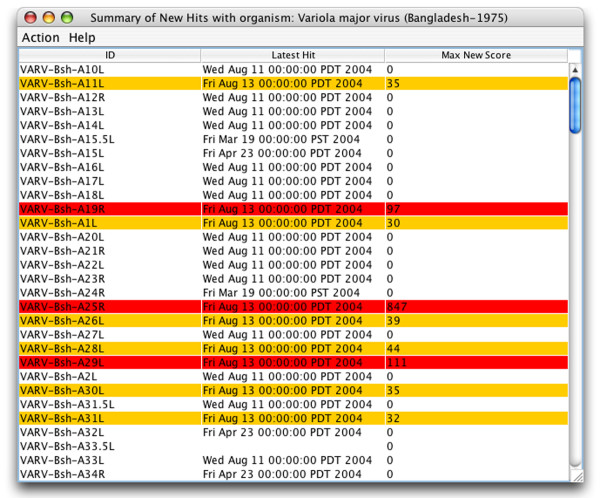
Query sequences with new hits are highlighted. A user defined threshold (in the Browser window) is used to define the minimum bit-score that is highlighted in red, and all new hits with lower scores are highlighted in yellow. The Latest Hit column indicates the date of the most recent hit. Those with no entry in this column have no hits in the database (for example, VARV-Bsh-A33.5L). Sorting of the entries can be changed by clicking on the column heading. Details about the hits can be obtained by right-clicking on the entry or selecting an option in the Action menu.